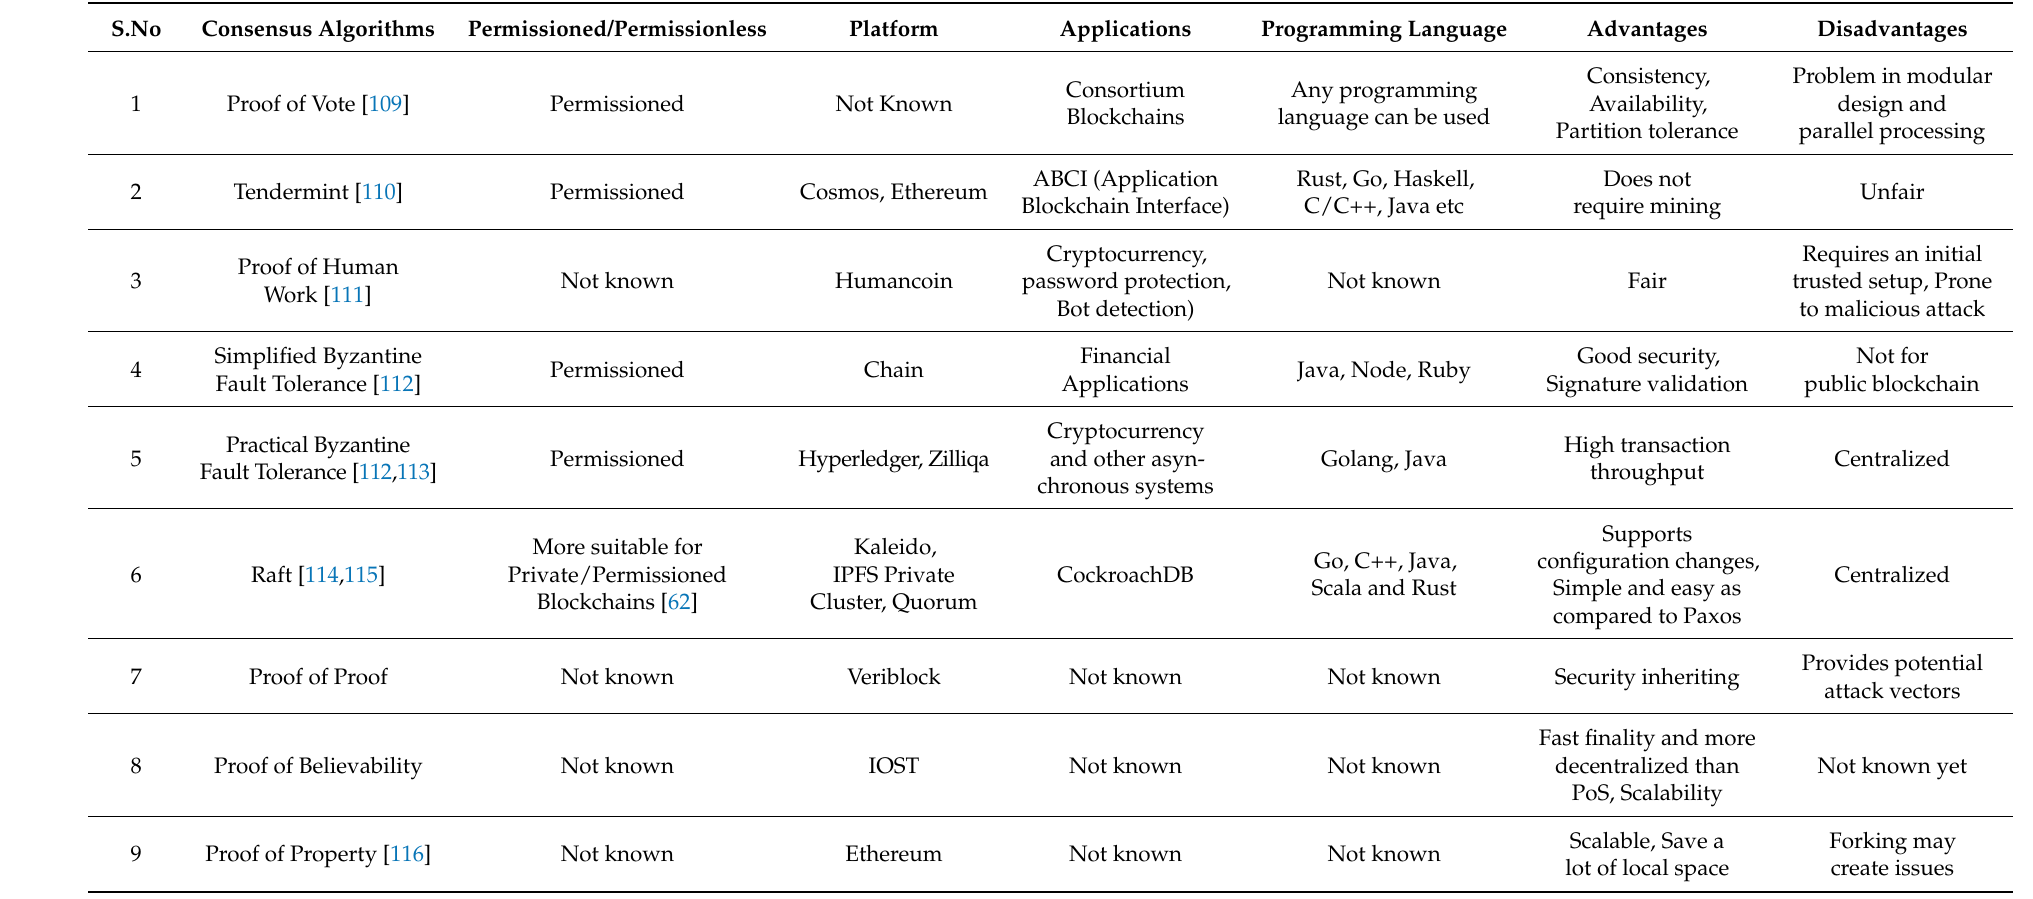
Table 4. Features of general consensus